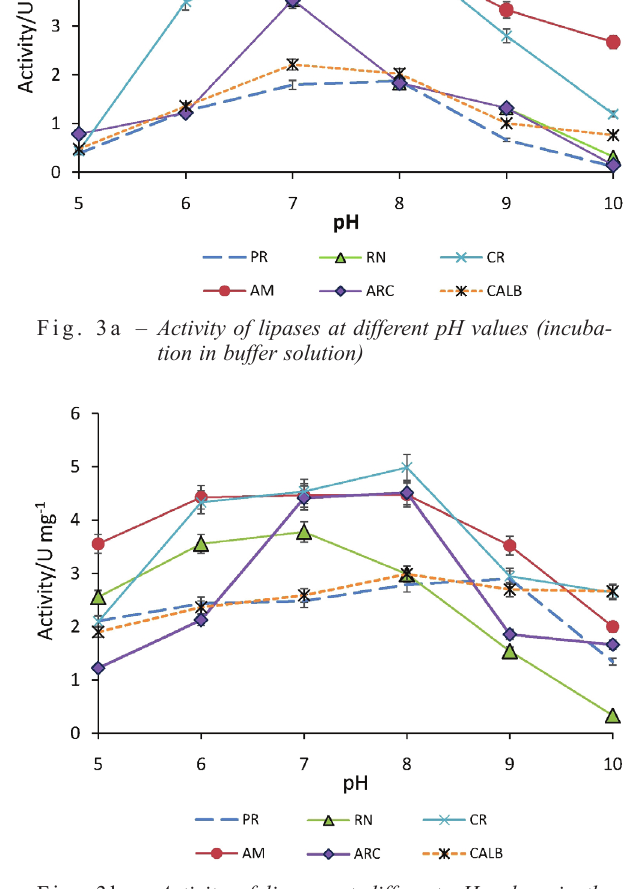
Fig. 3b – Activity of lipases at different pH values in the presence of NADES3